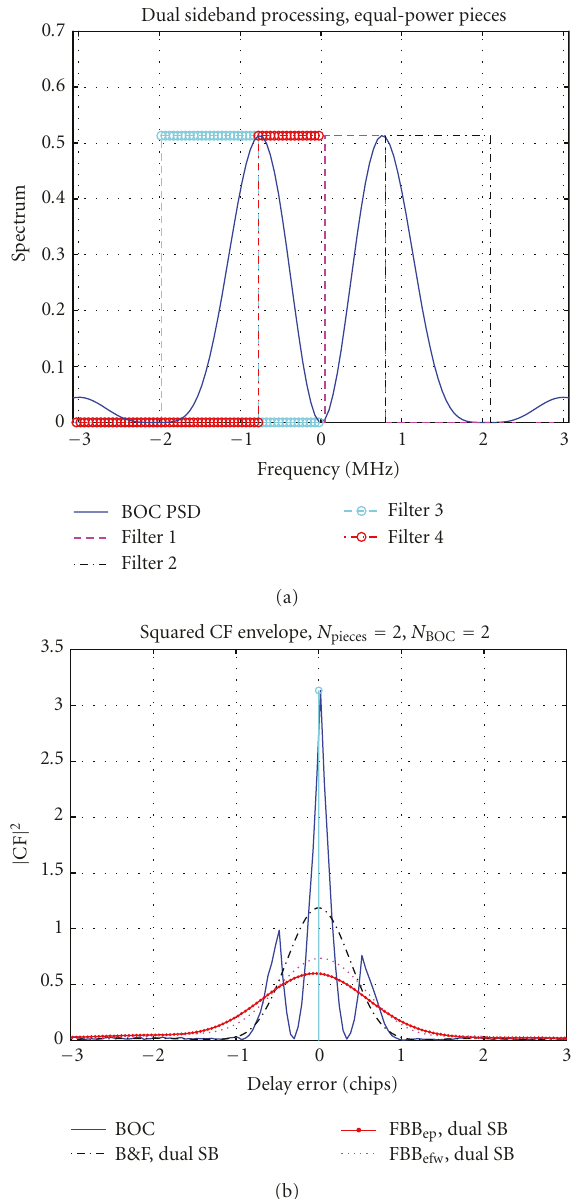
Figure 3: Illustration of the FBB acquisition methods, SinBOC(1,1) case. Upper plot: division into frequency pieces, via N fb = 4 filters (FBB ep method). Lower plot: squared CF shapes for 2 FBB meth- ods, compared with ambiguous BOC (aBOC) and unambiguous Betz&Fishman (B&F)